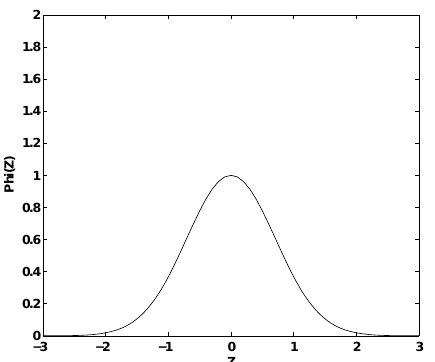
Figure 1. The shape of function ( ) z φ with 1 σ=